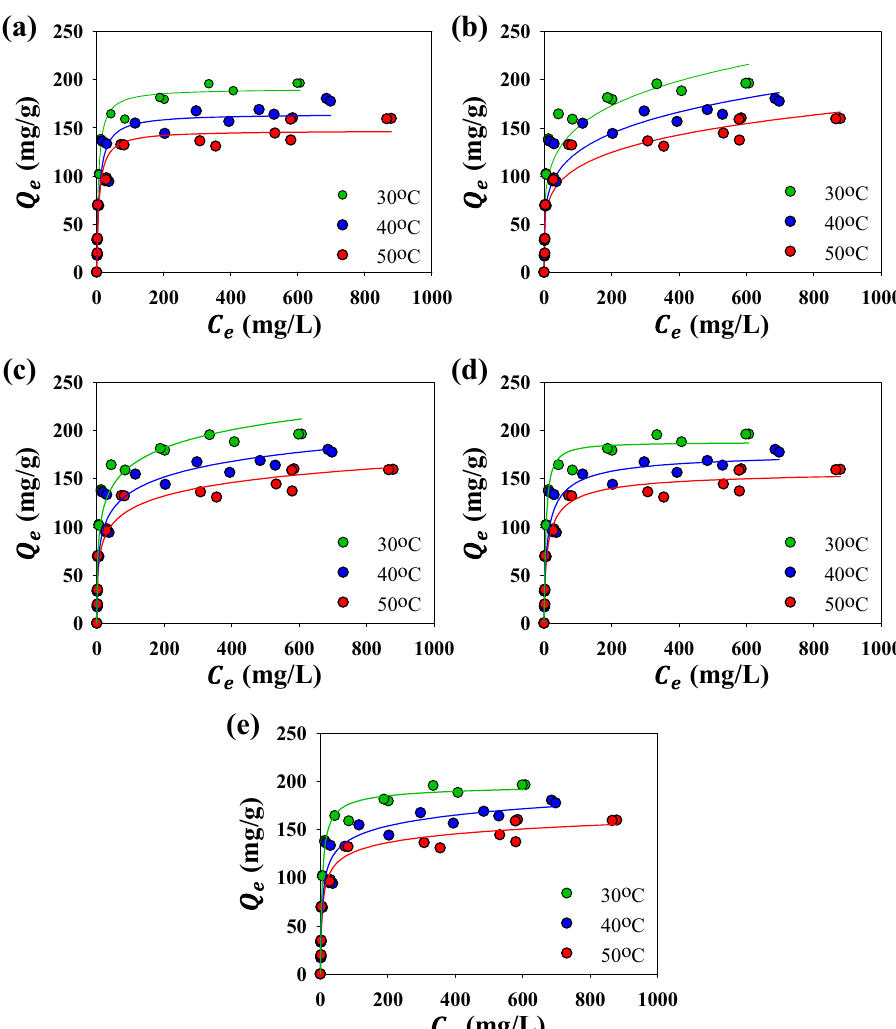
Figure 5. Adsorption isotherm of MB onto N g -CuGA. The solid lines represent the fits of Langmuir ( a ), Freundlich ( b ), Temkin ( c ), Sips ( d ), and Redlich–Peterson ( e ) isotherm models; symbols represent experimental